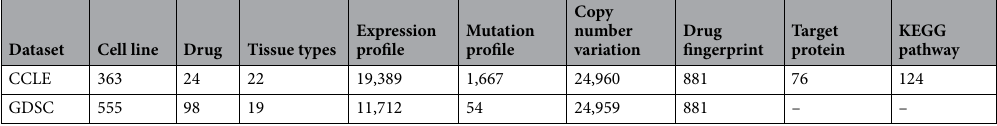
Table 1. The number of collected samples and features. The cell line features such as gene expression profile, mutation profile, copy number variation, tissue types, drug names, and drug response values were downloaded from PharmacoGx package, Drug fingerprints were obtained from pubchem, target proteins were gathered mainly from GDSC and DrugBank, and KEGG pathways were obtained from STiTCH